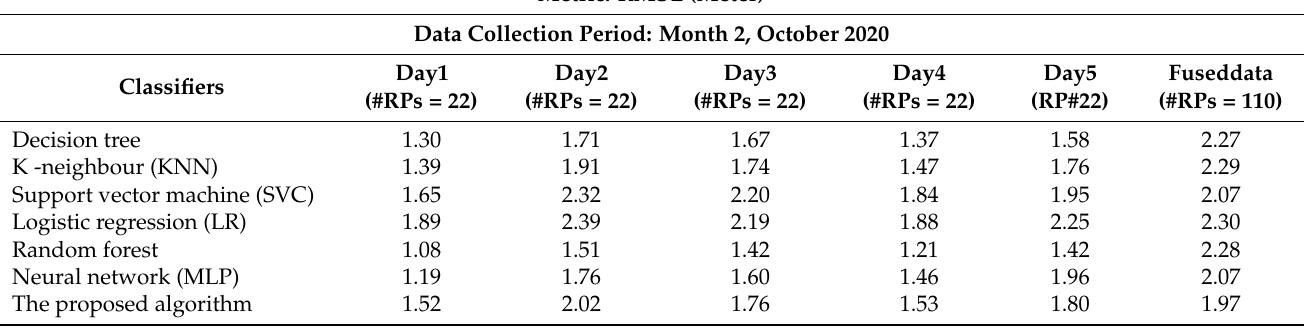
Table 8. Models vehicle’s indoor parking lots of CSI-based fingerprints of various datasets with different temporal variations.